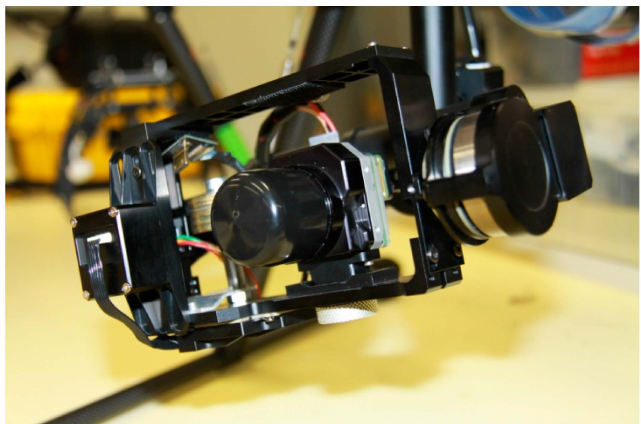
Figure 2. FLIR camera attached to the gimbal